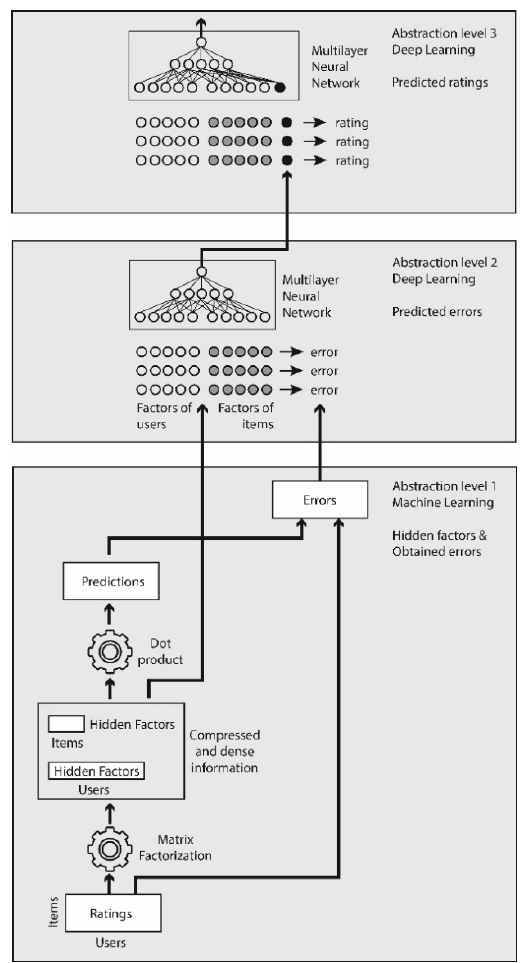
Figure 3. Proposed RNCF architecture.